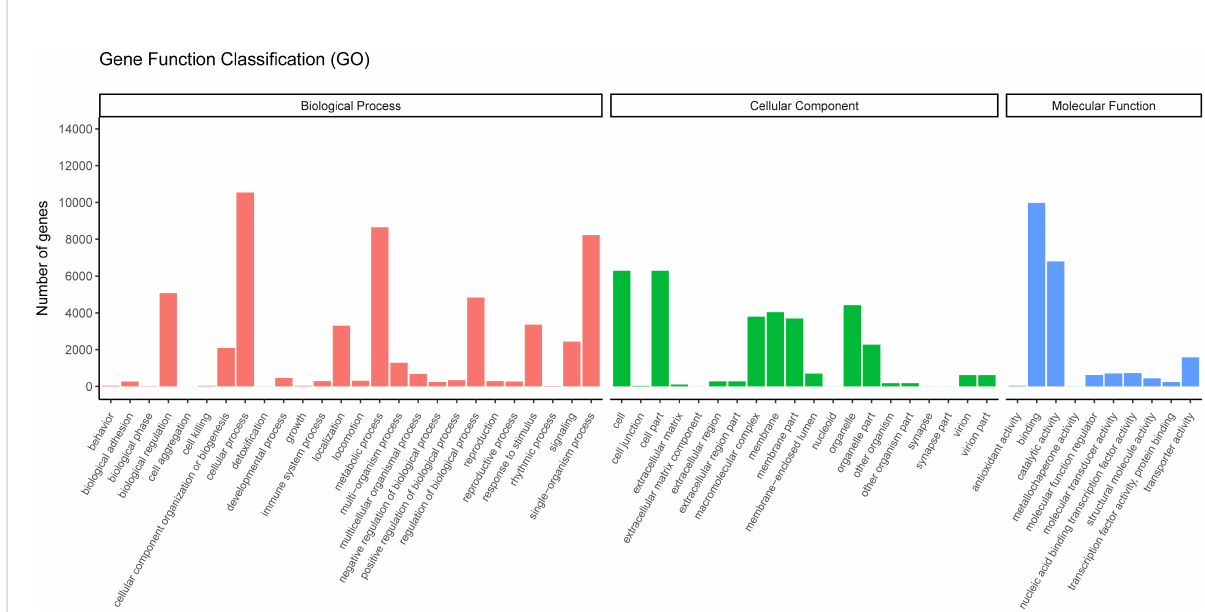
FIGURE 5 Gene ontology classi fi cations of assembled unigenes. A total of 17,372 unigenes were categorized into three functional categories: biological process, cellular component, and molecular